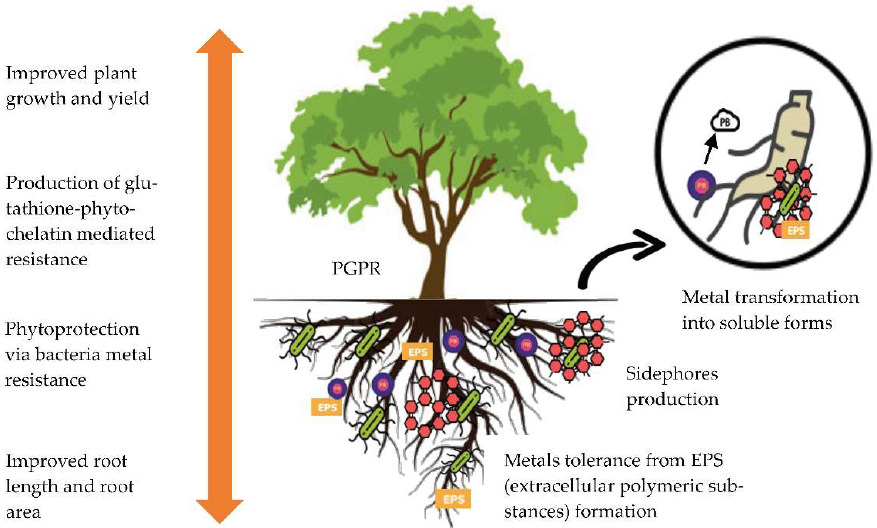
Figure 2. The mechanism of plant-microbe association that supports metals phytoremediation [64].